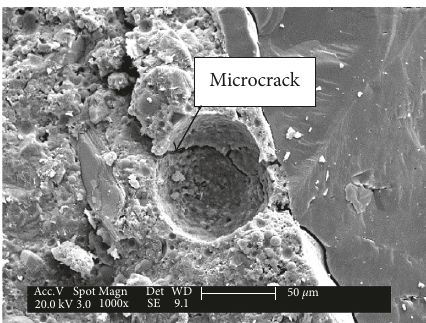
Figure 8: Microcracks in plain UHPC after the freezing-thawing tests.